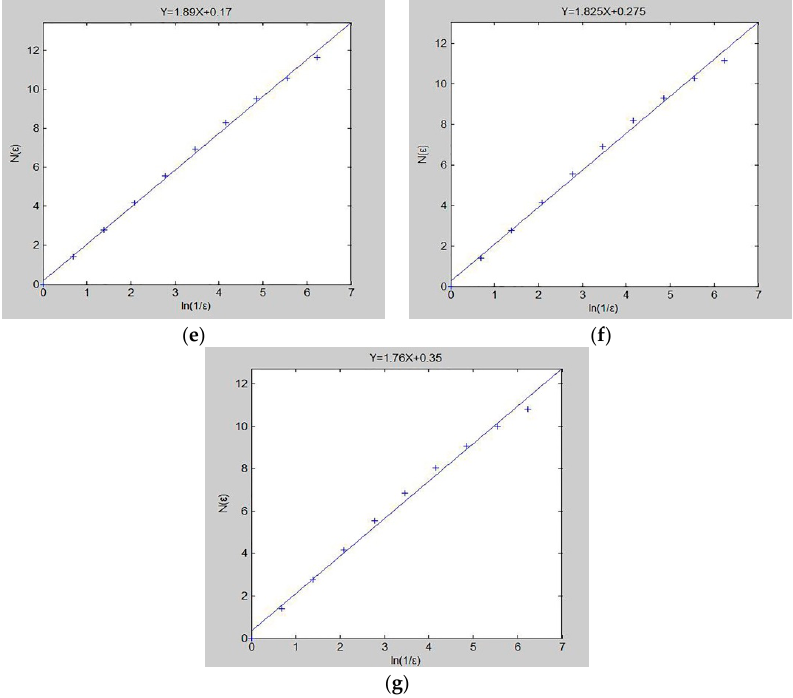
Figure 11. Calculation results of fractal dimension of samples (#1–7) ( a – g ). The slope of each straight line was the fractal dimension of the corresponding sample. After